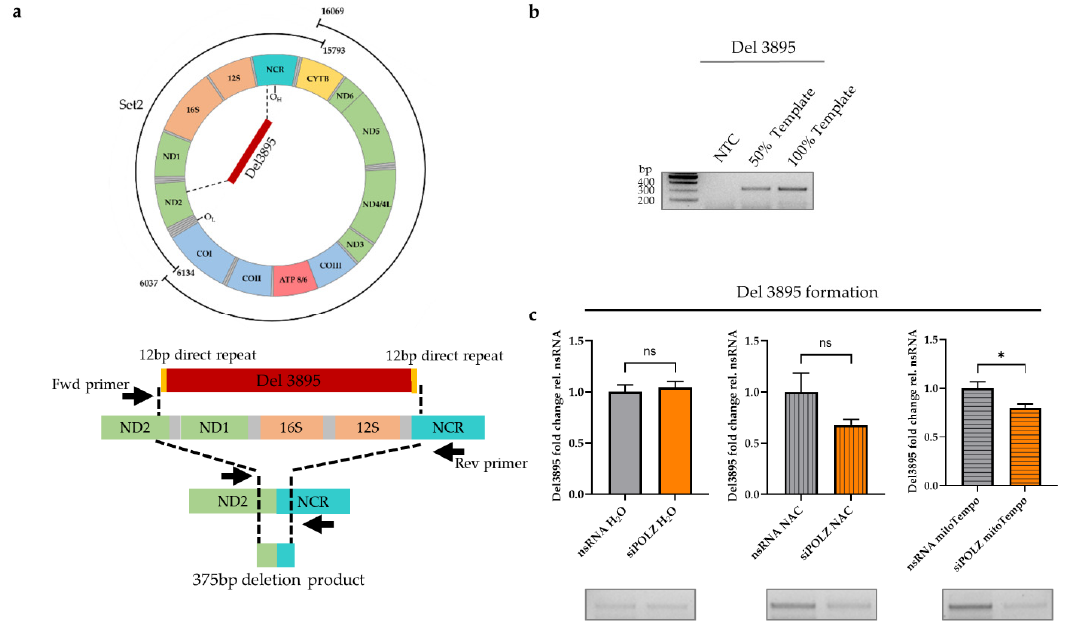
Figure 5. POLZ is involved in the Del3895 formation. Schematic presentation of the location of 3895 bp deletion ( upper ) and the location of primers for amplification of 375 bp generated by the 3895 bp deletion ( lower ) ( a ). Representative agarose gels of 375 bp deletion product confirming analysis in the linear range of PCR (50% template and 100% template) ( b ) and quantification of Del3895 deletion product from HeLa cells cultured in galactose medium, siRNA-mediated knockdown for 48 h plus 24 h treatment with 100 µM mitoTempo or 2 mM NAC ( n = 10 from 5 independent experiments) ( c ). Representative agarose gels are shown below the graphs. All values are means ± SEM (* p ≤ 0.05); ns, not significant.